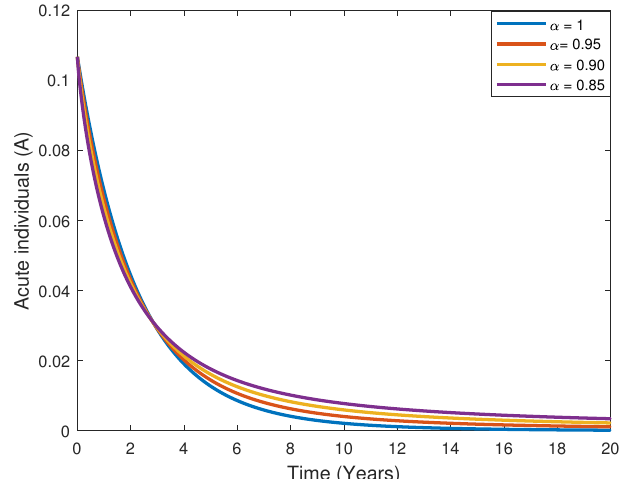
Figure 5. Behavior of A class for different α values.